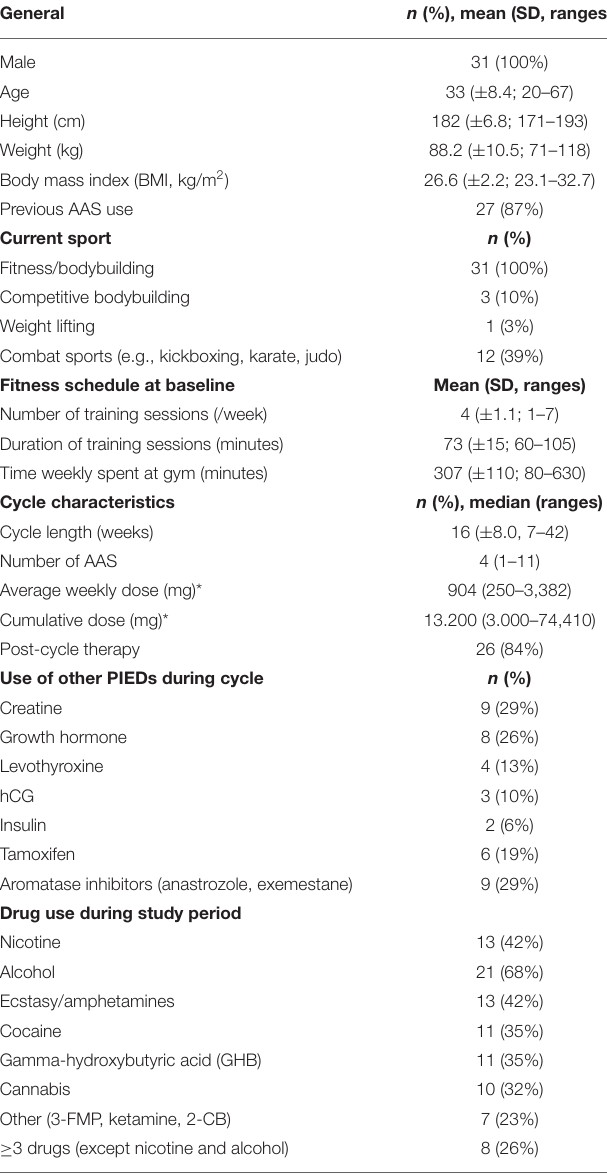
TABLE 1 | Baseline characteristics, AAS cycle characteristics and details of drug abuse of the 31 subjects of the HAARLEM study included for echocardiography.